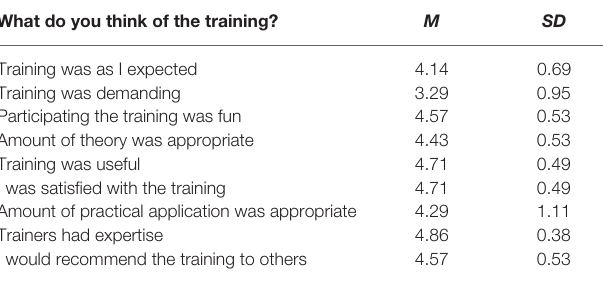
TABLE 3 | The descriptive statistics of the novice instructors’ evaluations of the acceptability of the training